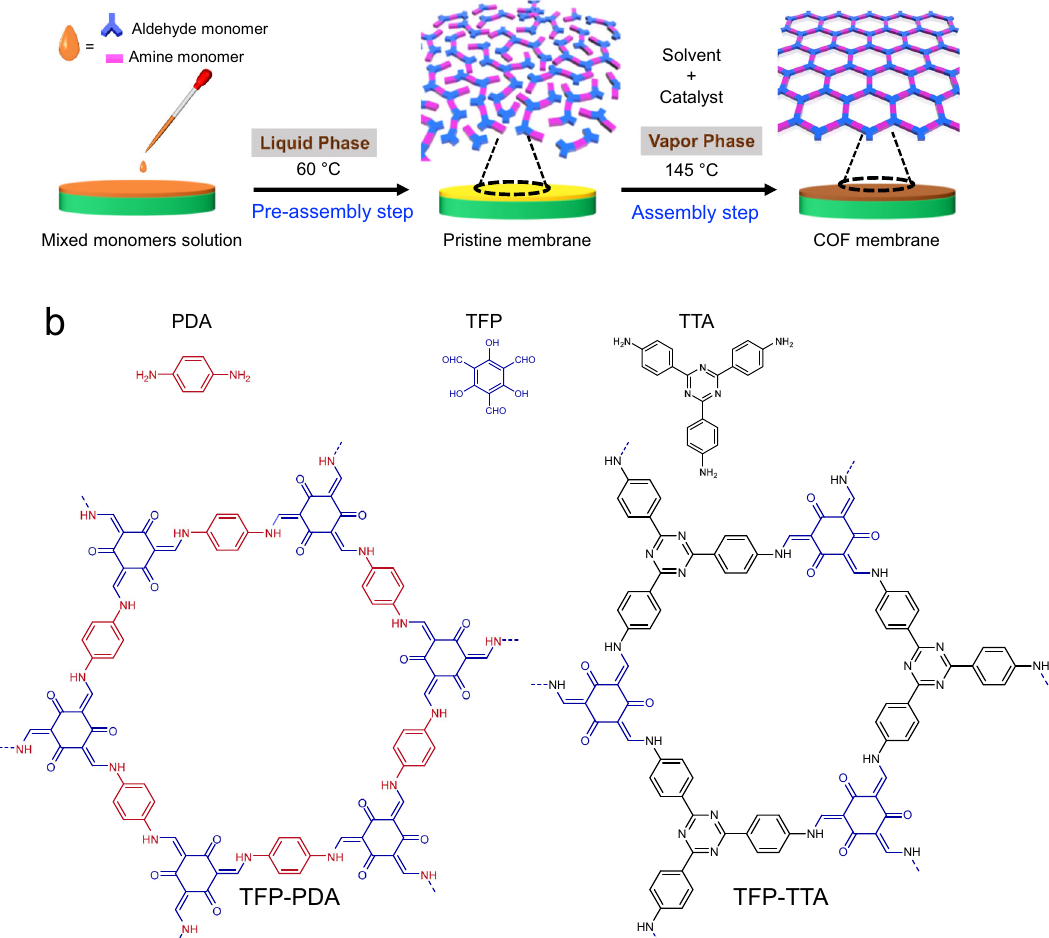
Fig. 1 Schematic illustration of the membranes fabrication. a Casting mixed monomer solution on ITO substrate in the pre-assembly step to obtain pristine membrane at 60 °C, subsequently heating the pristine membrane at 145 °C in the assembly step to fabricate COF membranes. b Chemical structure of the two COF